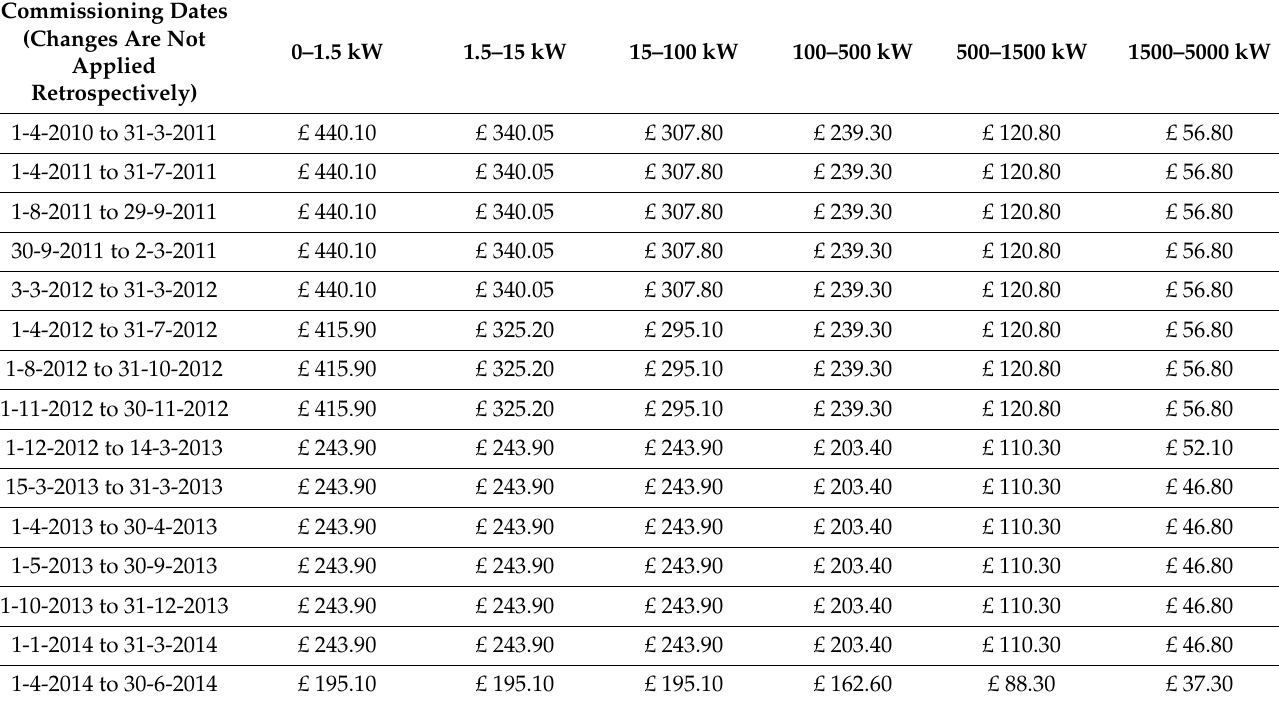
Table A1. Prices per MWh of Wind Turbine Generation under Ofgem FiT